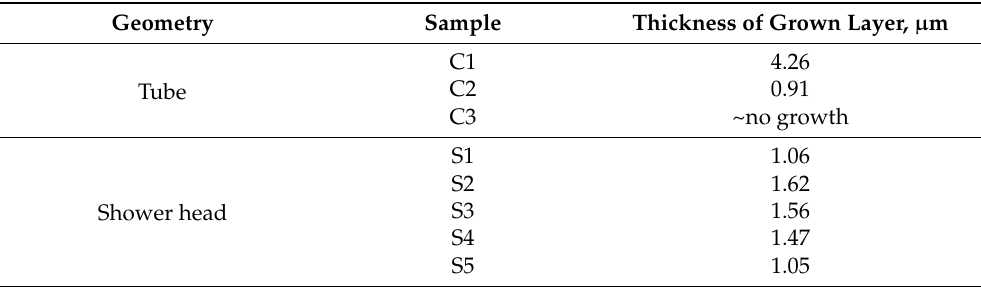
Table 1. Thickness of samples grown with two geometries: tube and shower head.